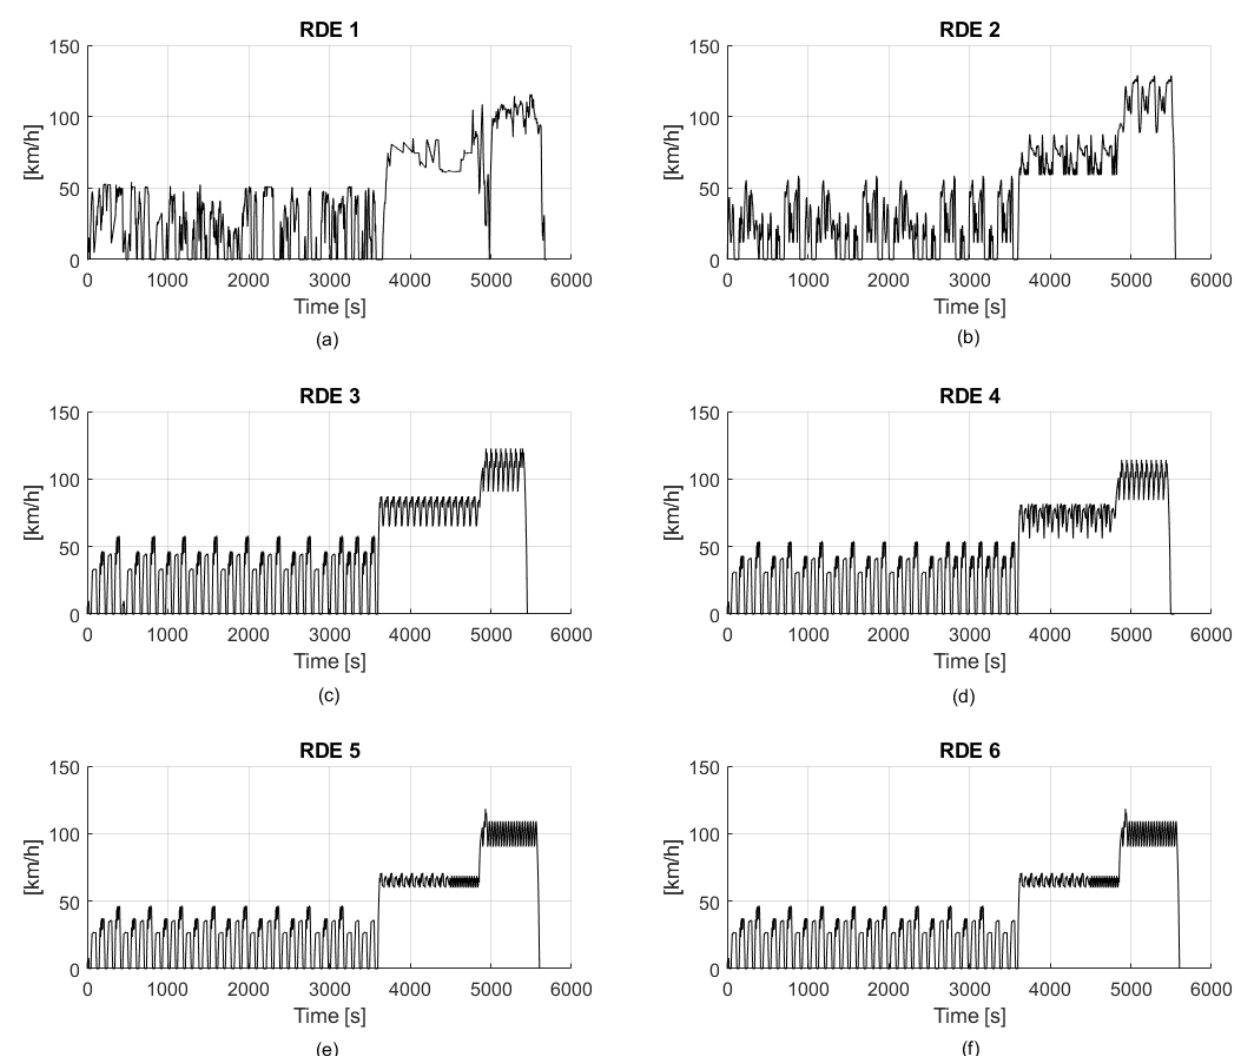
Figure 2. RDE 1 ( a ), RDE 2 ( b ), RDE 3 ( c ), RDE 4 ( d ), RDE 5 ( e ), and RDE 6 ( f ) vehicle speed pro- files. Table 4. RDE cycles characteristics.